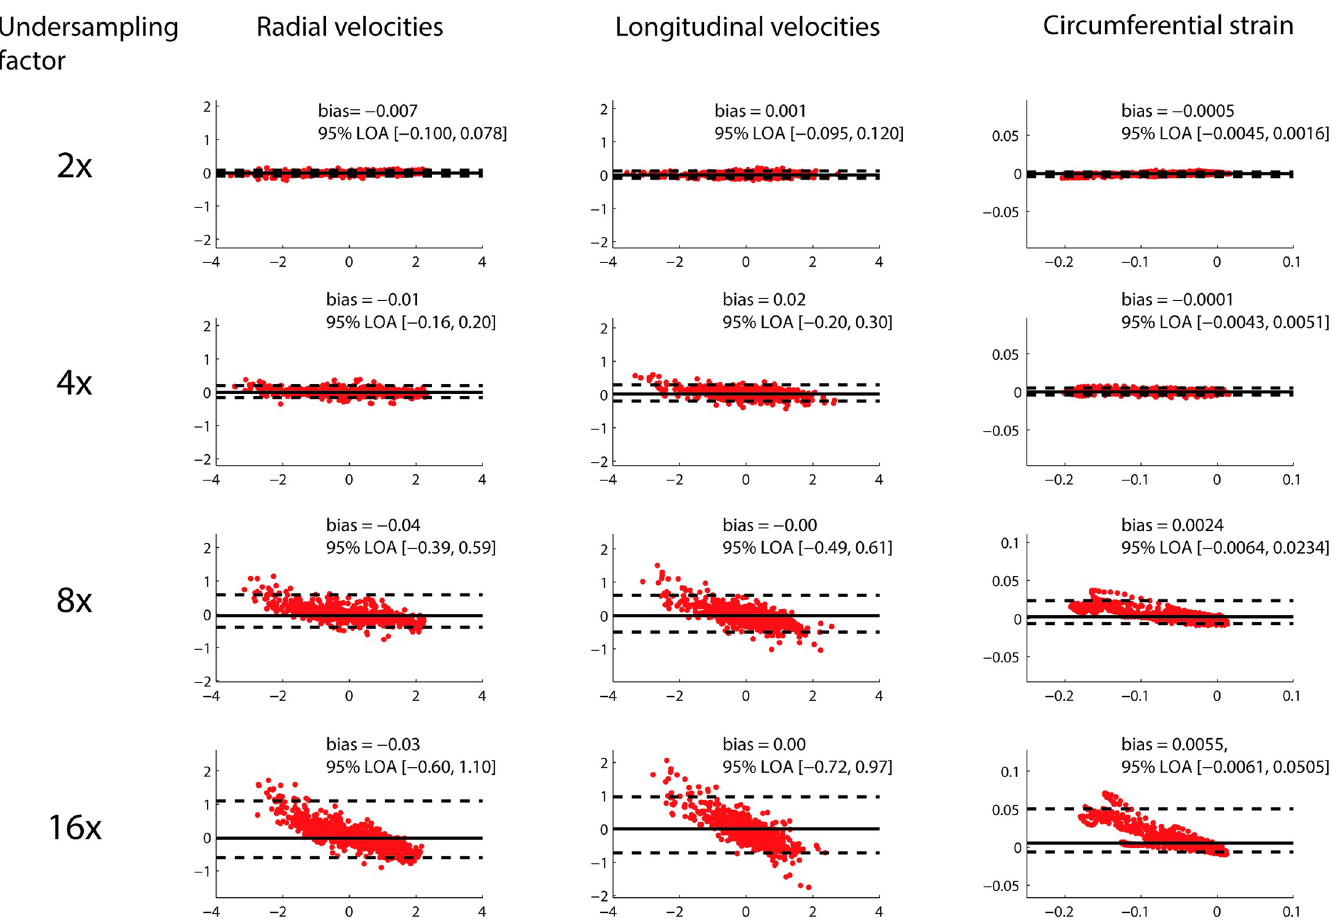
Fig 5. Global velocities. Bland Altman comparison of global radial velocities, longitudinal velocities, and circumferential strain from the midventricular slice, for a variety of undersampling factors.